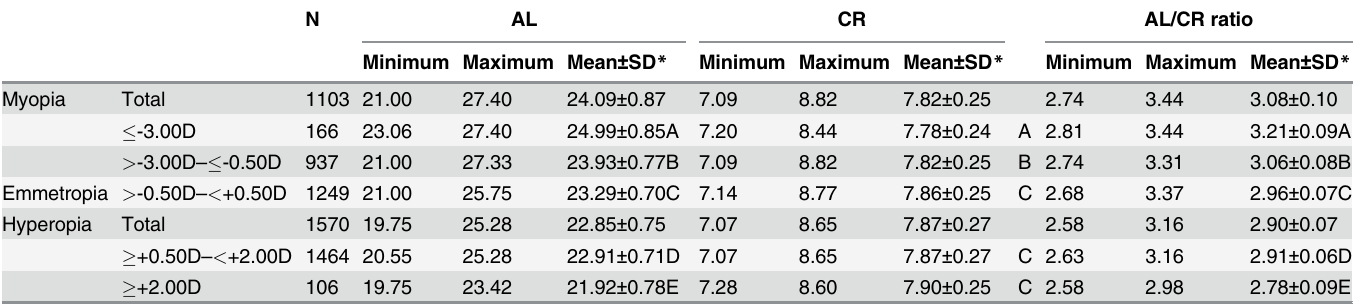
Table 3. Mean values of AL, CR and AL/CR ratio according to refractive status. N AL CR